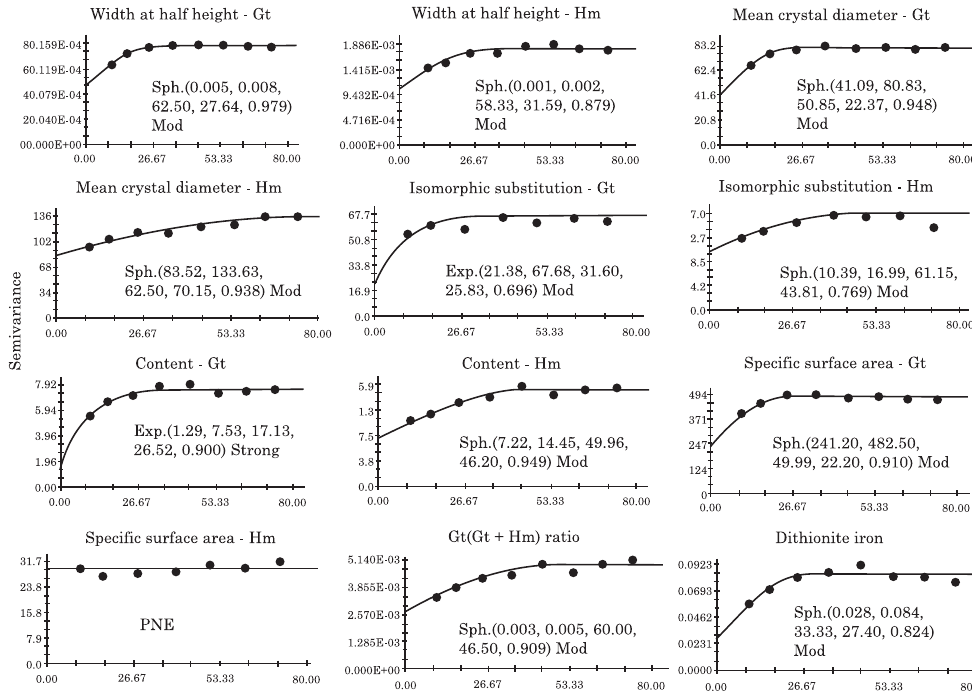
Figure 2. Semivariograms of the studied attributes in the convex area. Gt: goethite, Hm: hematite, PNE: Pure nugget effect, Sph.: Spherical, Exp.: Exponential, Mod: Moderate. Sequence of the semivariogram parameters: C o ; C 1 ; C o / (C o + C 1 ) (%); range; r 2